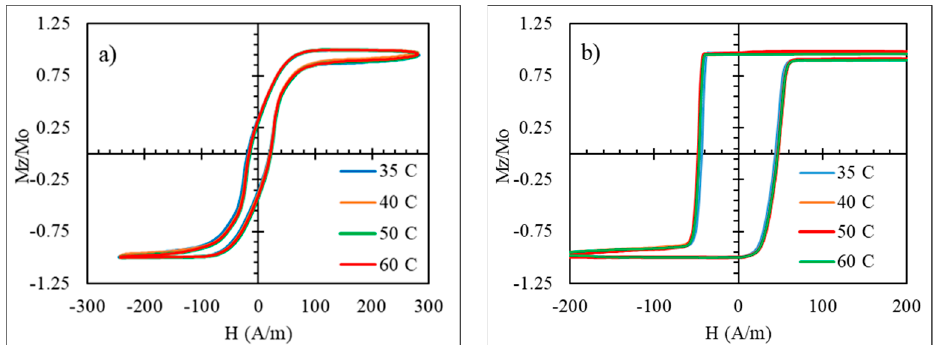
Figure 12. Effect of tensile stress on the amplitude of 11th harmonics of glass-coated amorphous Co 71 Fe 5 B 11 Si 10 Cr 3 microwires in an as-prepared state and after current annealing at 60 mA (122 A/mm 2 ) for 60 min (compare with the change in the hysteresis curves shown in Figure 7).